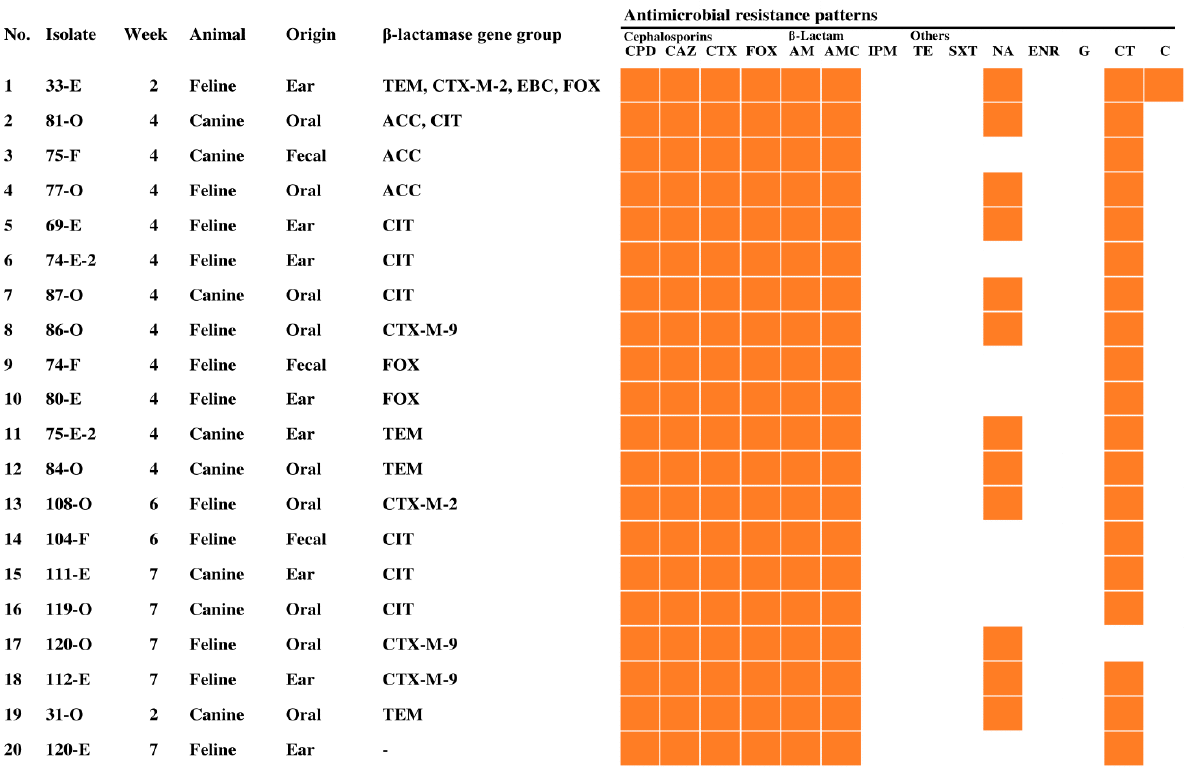
Figure 3. Characteristics of 20 ESBL- and pAmpC β -lactamase-producing K. pneumoniae isolates from dogs and cats. CPD, cefpodoxime; CAZ, ceftazidime; CTX, cefotaxime; FOX, cefoxitin; AM, ampicillin; AMC, amoxicillin-clavulanate; IPM, imipenem; TE, tetracycline; SXT, trimethoprim/sul- famethoxazole; NA, nalidixic acid; ENR, enrofloxacin; G, gentamicin; CT, colistin; C, chloramphen- icol.